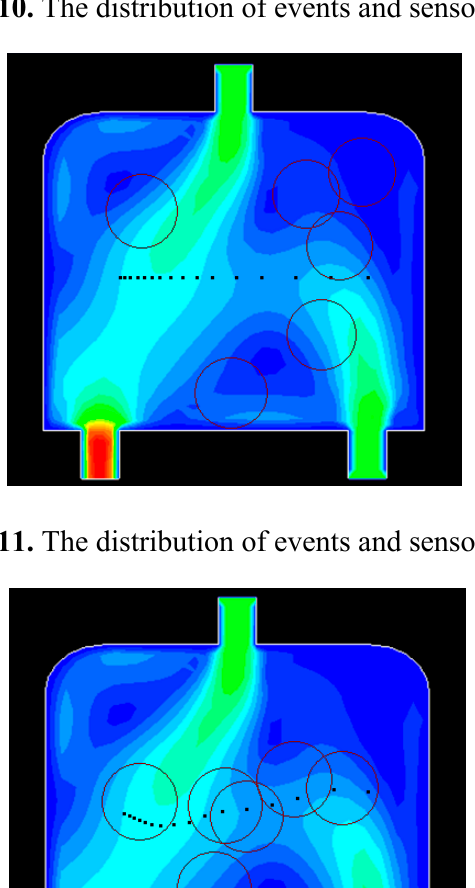
Figure 10. The distribution of events and sensors at t1.